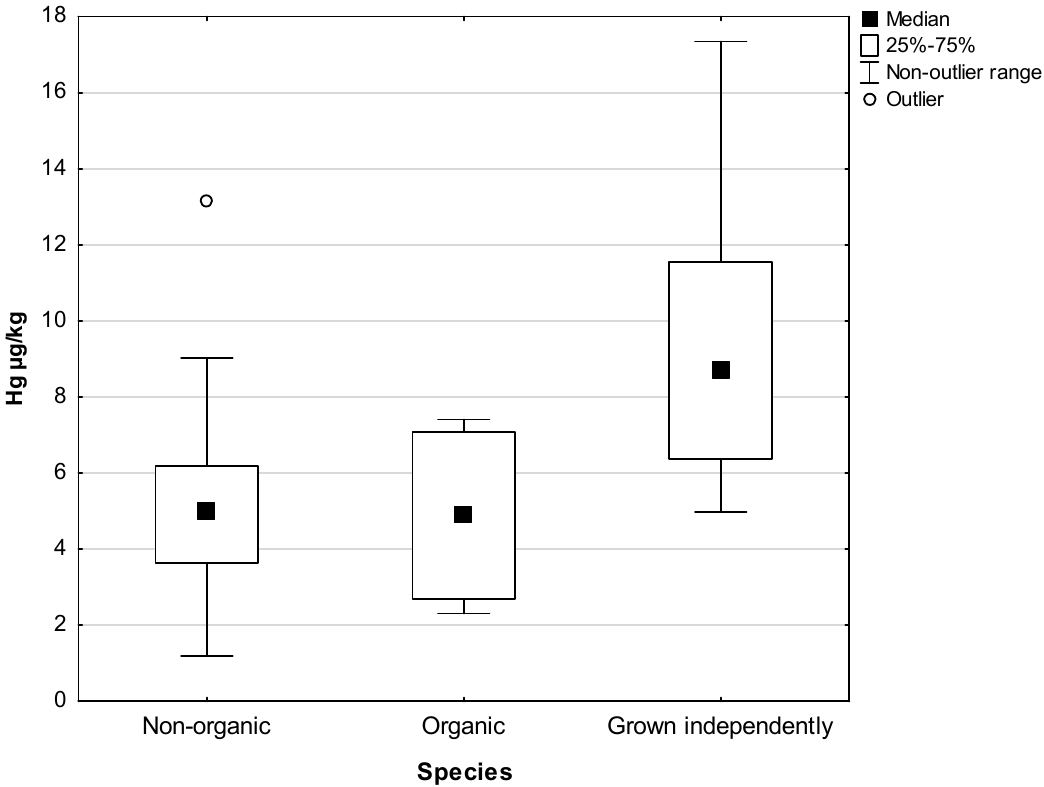
Figure 1. Hg concentration in organic and non-organic spices purchased in stores and grown in- dependently, µg/kg. independently, µ